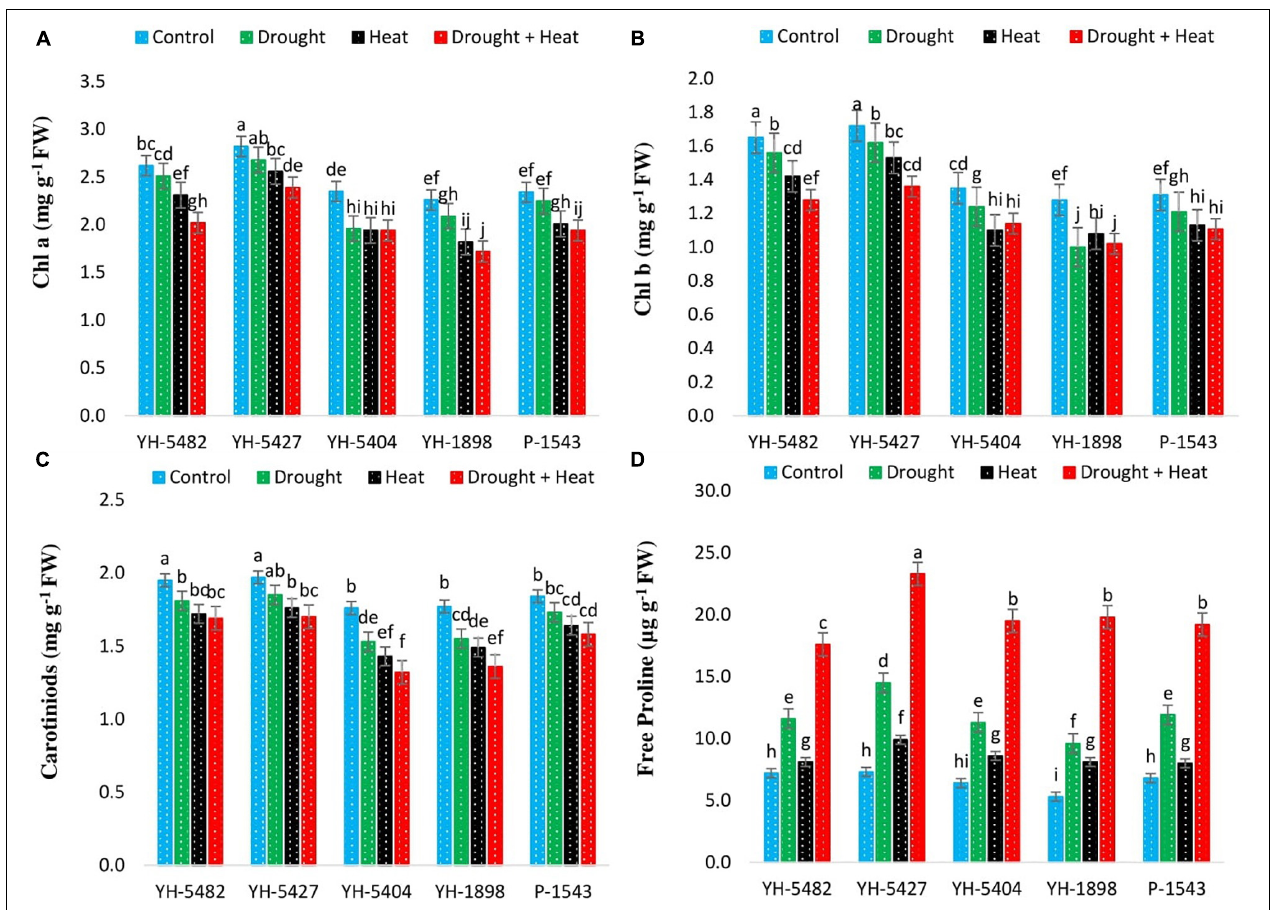
FIGURE 5 | Effect of heat, drought, and heat +drought stress on (A) Chlorophyll an (B) Chlorophyll a (C) Carotenoid Contents, and (D) Free Proline Contents in five maize hybrids. Capped bars above means represent the ± SE of three